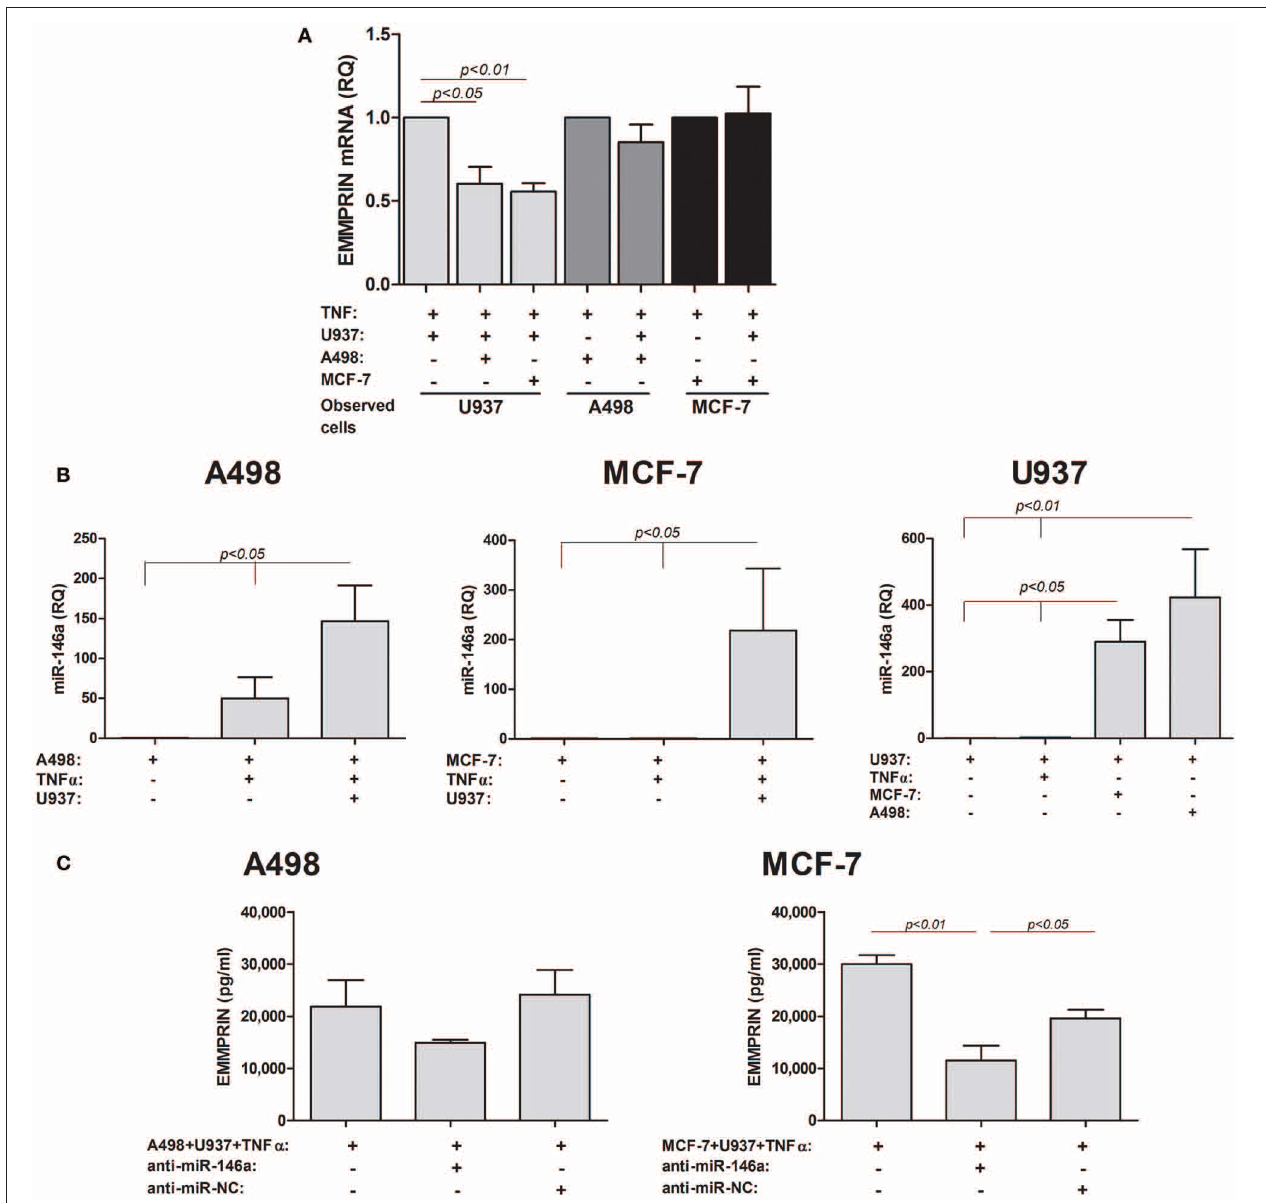
FIGURE 2 | EMMPRIN is regulated at the post-transcriptional level. 0 . 6 × 10 5 A498 or MCF-7 cells were incubated in single- or co-cultures with 0 . 3 × 10 5 U937 cells in the presence of TNF α (1ng/ml) for 48h. To allow estimation of mRNA or miRNA levels in each cell type, co-cultured cells were incubated in separate inserts (0.3 μ m pore size), thus precluding cell migration between the two compartments. In some of the wells cells were transfected with anti-miR-146a or anti-miR-NC